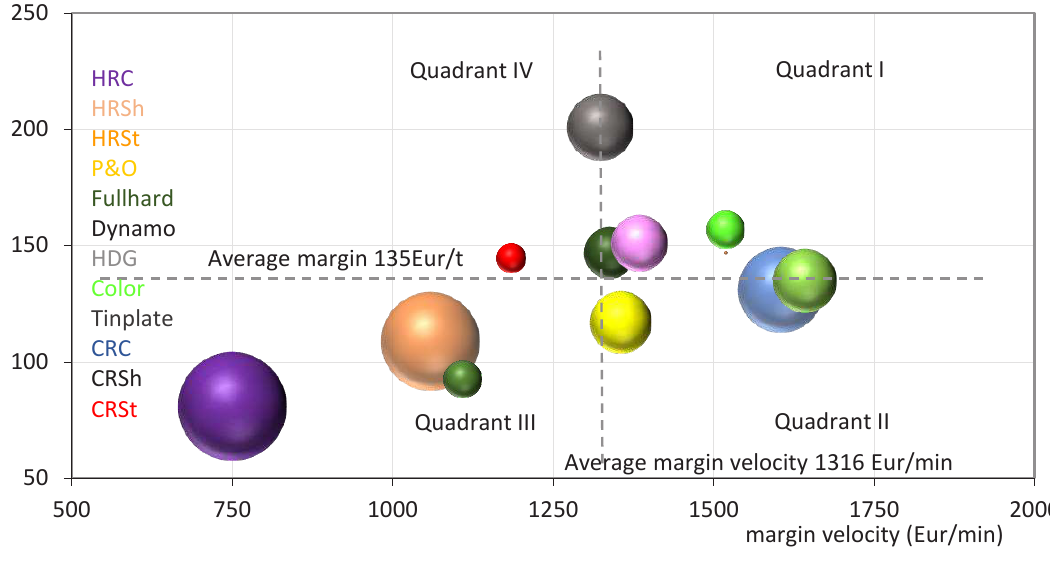
Figure 3. Graph of change in margin velocity of